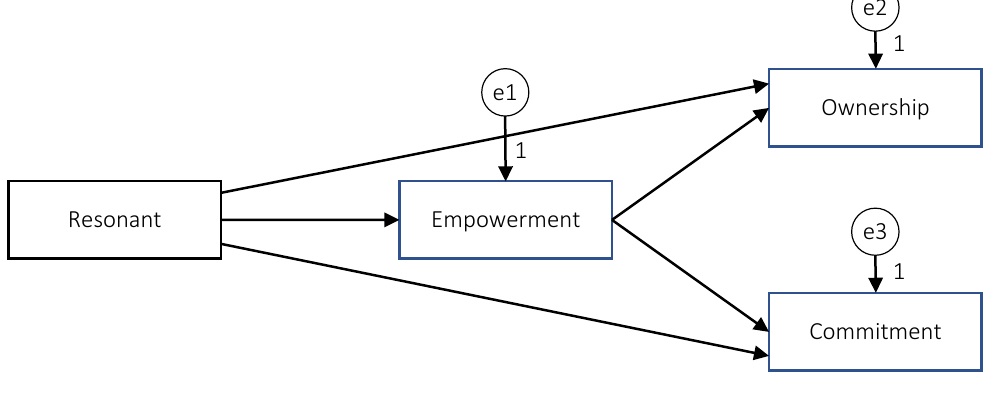
Figure 3. Partially mediated model